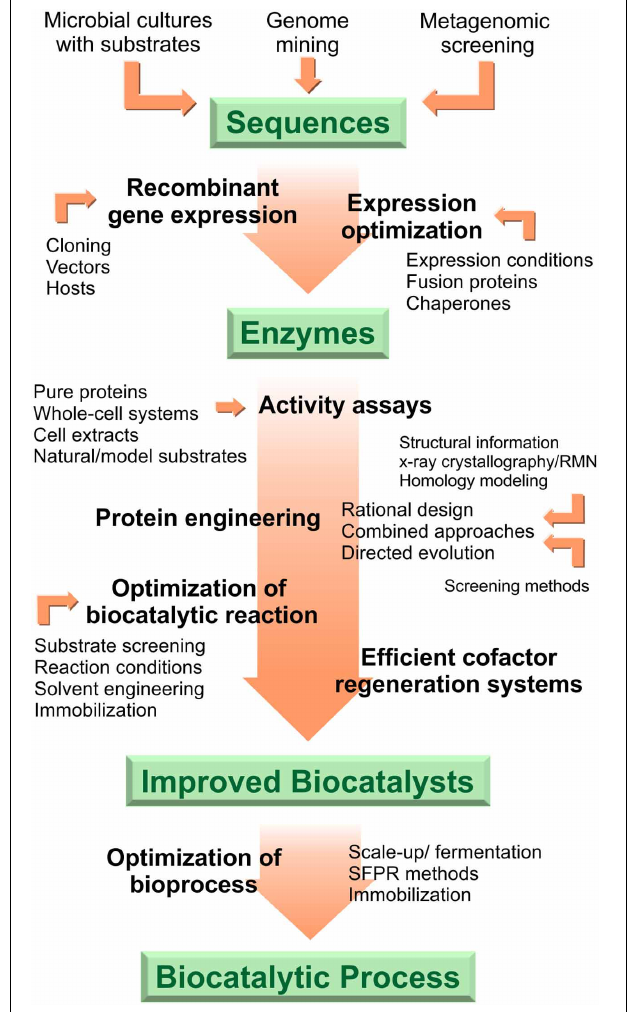
FIGURE 2 | General strategy for the development of recombinant